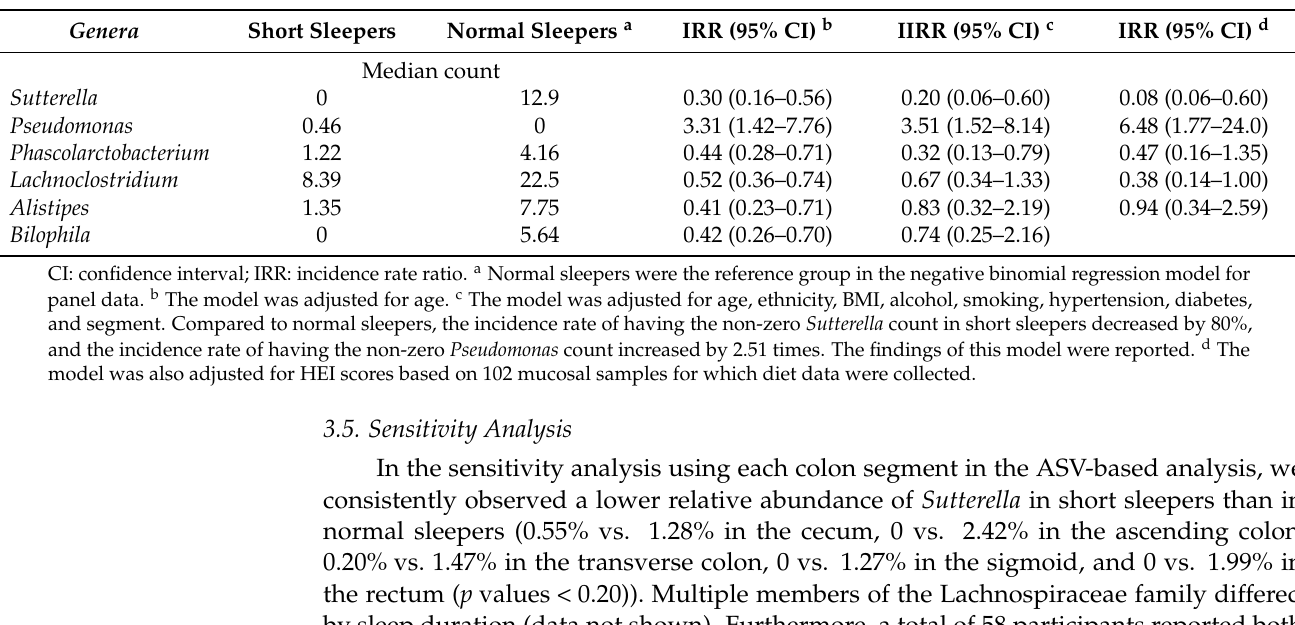
Table 3. The incidence rate ratio (IRR) of having non-zero bacterial count in short versus normal